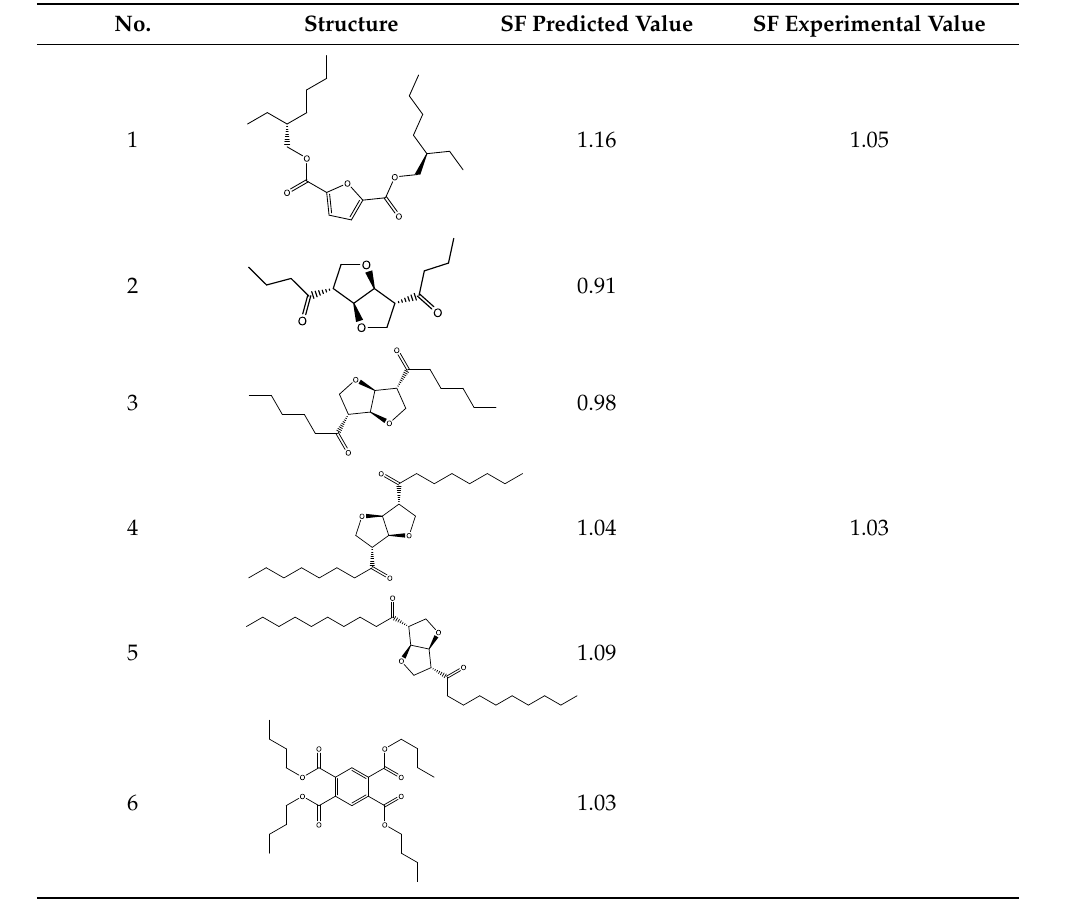
Table 6. Structure and predicted values of several bio-based plasticizers.